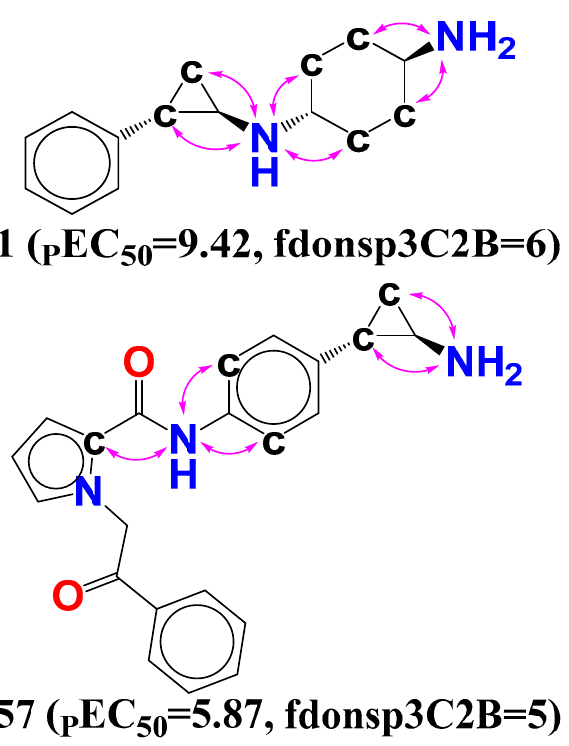
Figure 8. Pictorial display of molecular descriptor fdonsp3C2B for the molecules 1 and 57